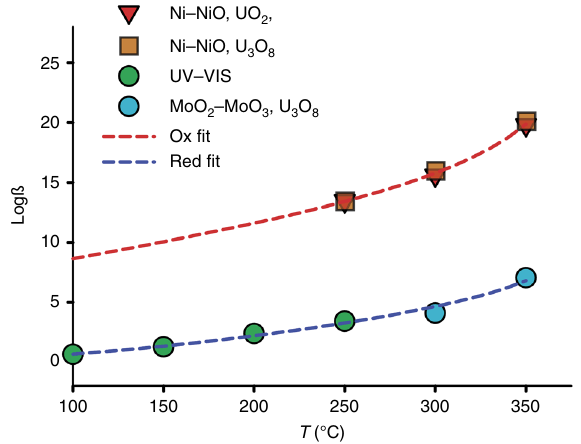
Fig. 2 Comparison of formation constants determined in this study to those previously reported. Formation constants for UCl 4 ° at reducing conditions (Ni – NiO oxygen fugacity buffer) were fi tted to the Bryzgalin – Ryzhenko model (red dashed line). Regardless of whether the experiments used UO 2 cryst or U 3 O 8 cryst , the resulting formation constants are indistinguishable. Uncertainties for the formation constants are smaller than the symbols. A similar fi t for UO 2 Cl 2 ° at oxidizing conditions (blue dashed line) demonstrates that the data obtained in this study (blue circles) are consistent with those of ref. 21 (green